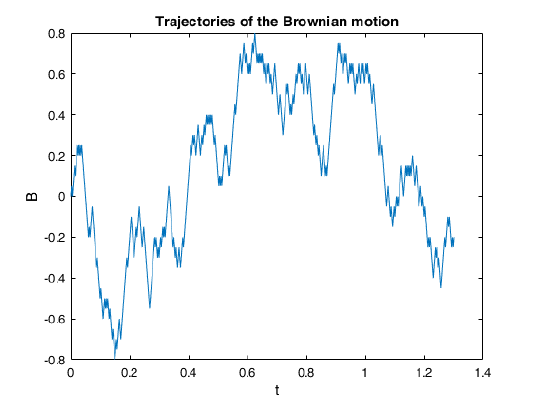
Figure 1. One path of the Brownian motion.